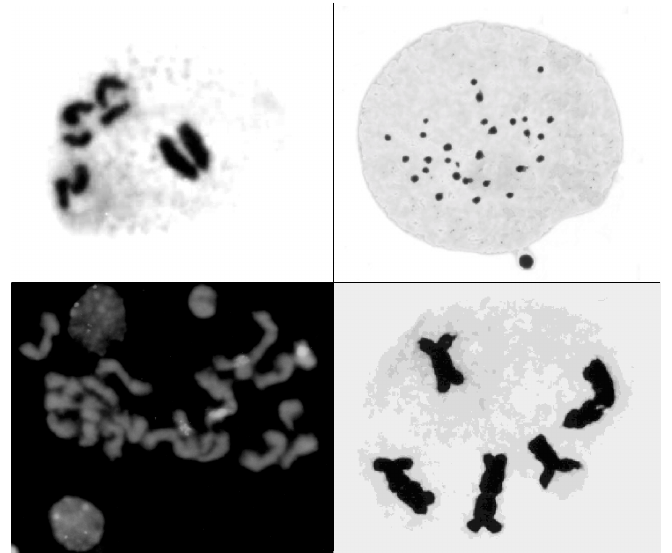
F L A IRST ATIN MERICAN C YTOGENETICS AND